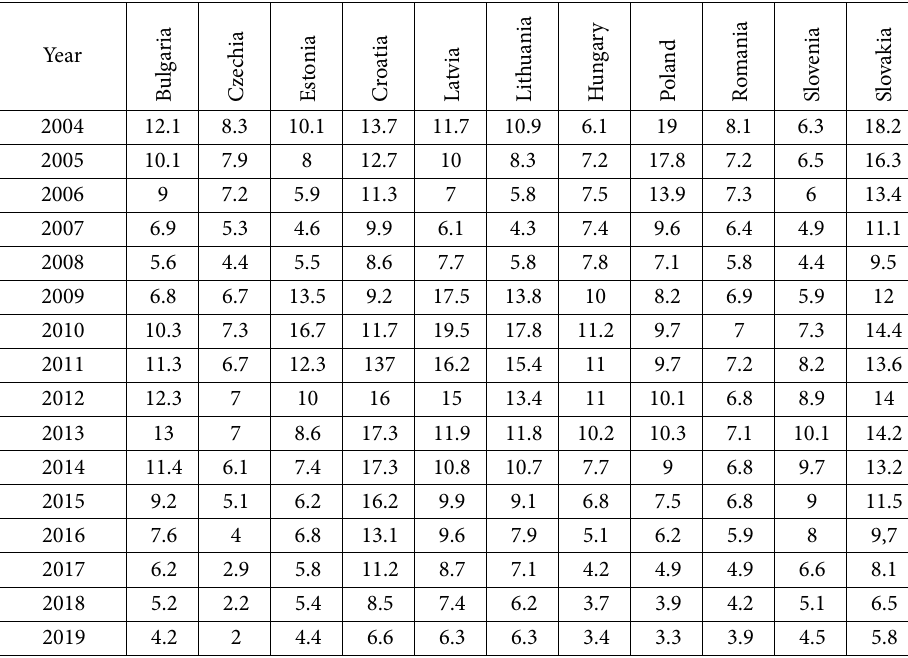
Table 1. Unemployment rate in CEE countries (2004–2019)